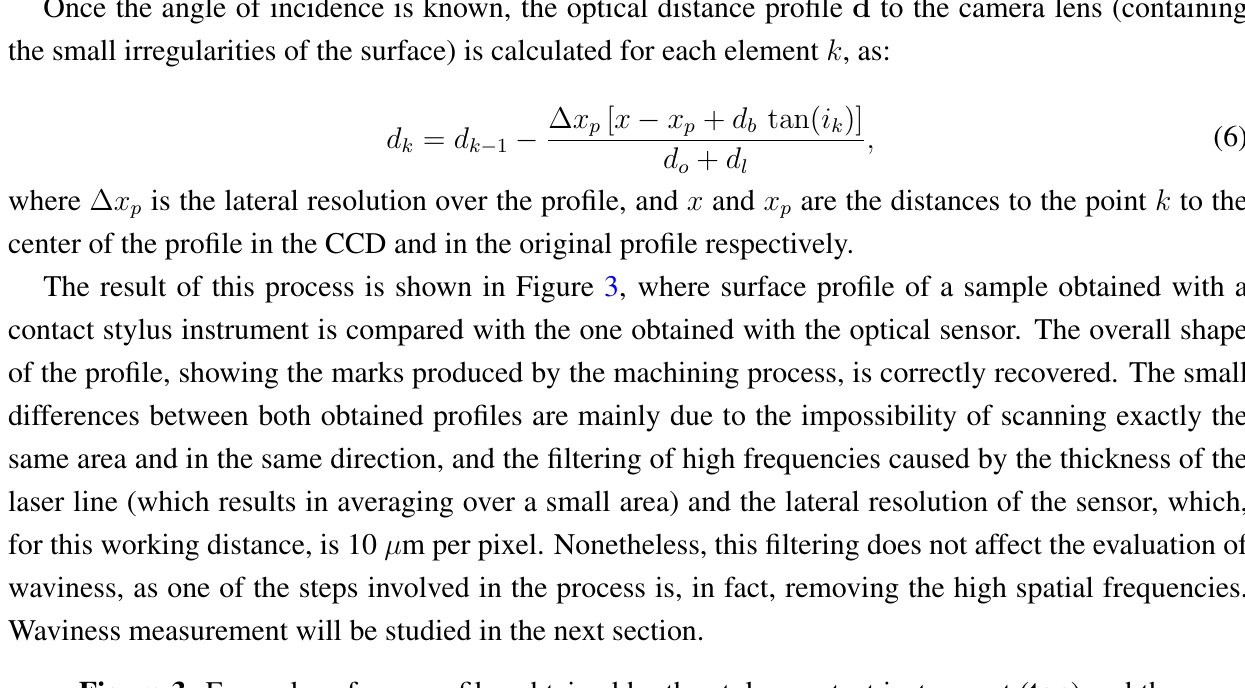
Figure 3. Examples of raw profiles obtained by the stylus contact instrument ( top ) and the optical profilometer ( down